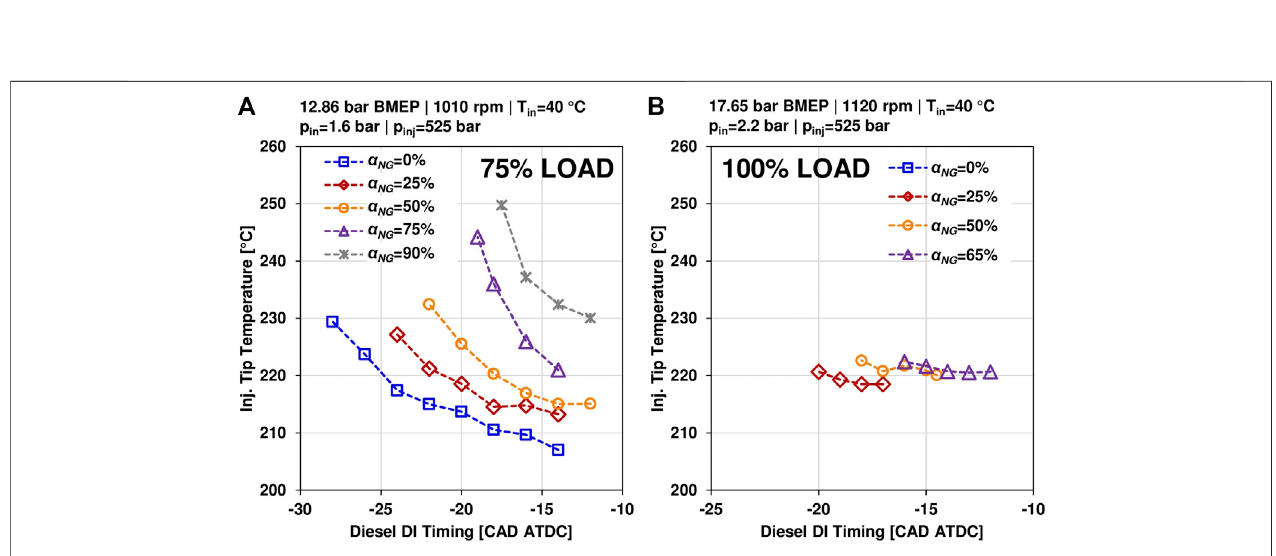
FIGURE 8 | Injector tip temperature – (A) . 75% load; (B) . 100% load.